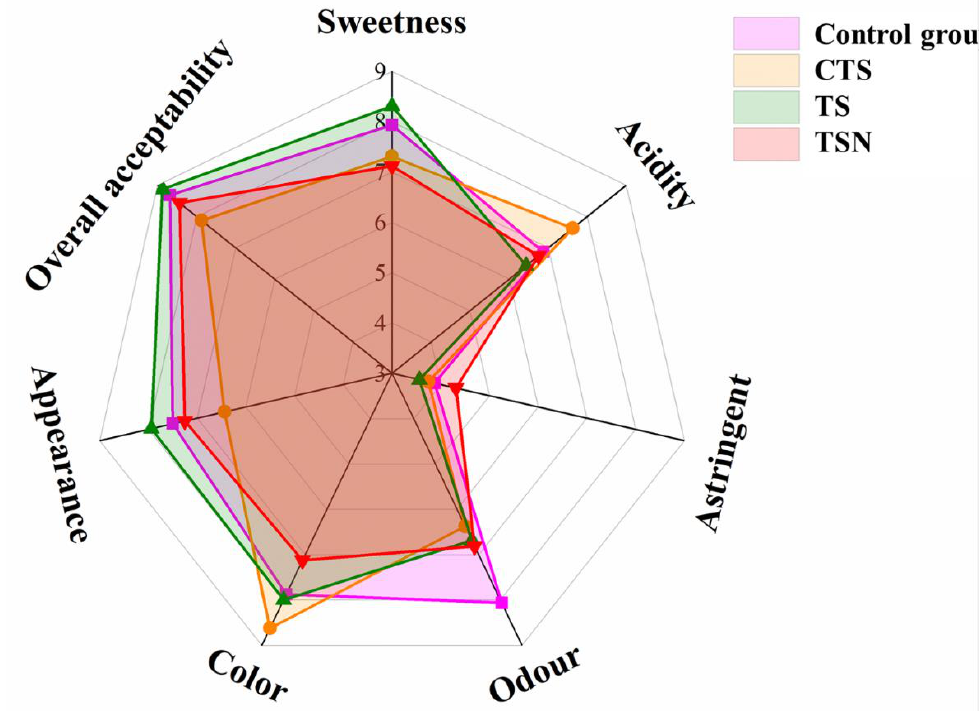
Figure 7. Spider plot of artificial sensory evaluation on grape juice under different sterilization treatments.